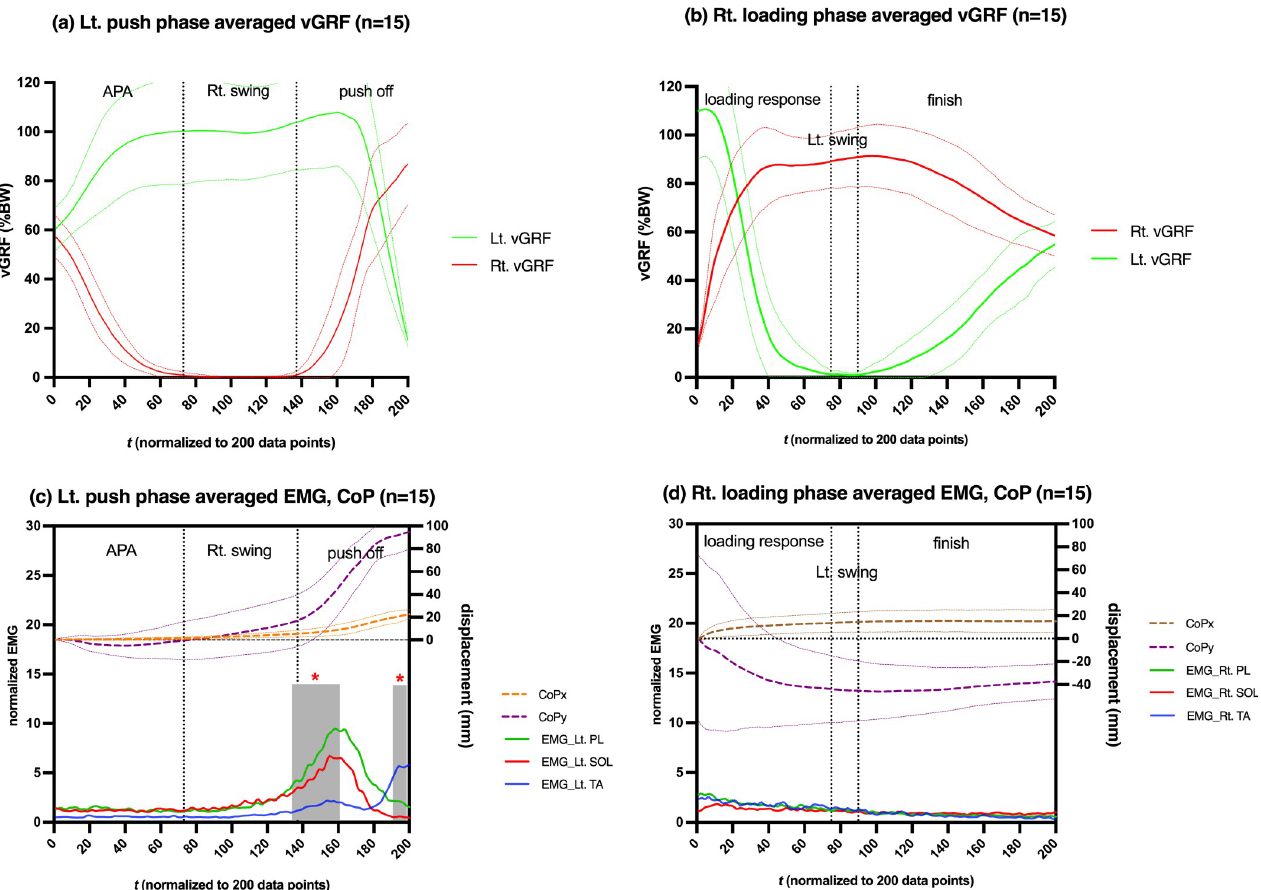
Fig 4. The change in (a,b) bilateral vGRF, and (c,d) ipsilateral normalized EMG amplitudes and CoP displacement during the step-aside movement. Data on the plot represent the means from 15 subjects. SDs are not shown on EMG amplitudes for clarity purposes. Gray boxes on (c) indicate statistically significant different regions between EMG activations from SPM1d analysis. � : p < 0.05. Two vertical dotted lines divide each phase into three periods, respectively. APA: anticipatory postural adjustment.